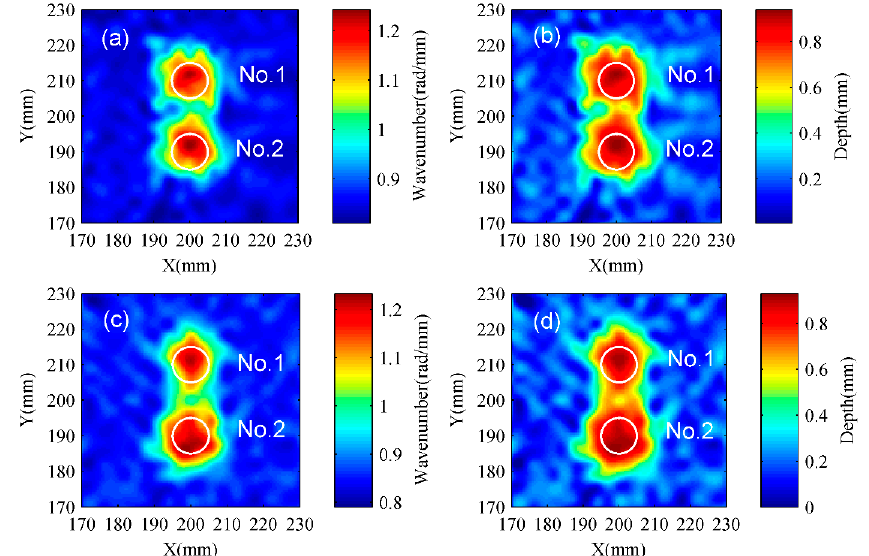
Figure 19. Experimental results of Case 5 and Case 7. ( a ) Wavenumber distribution of Case 5; ( b ) depth distribution of Case 5; ( c ) wavenumber distribution of Case 7; ( d ) depth distribution of Case 7. The white circle represents the actual location of the damage. The actual depth of the defect is 1 mm. Appl. Sci. 2018 , 8 , x 20 of 28